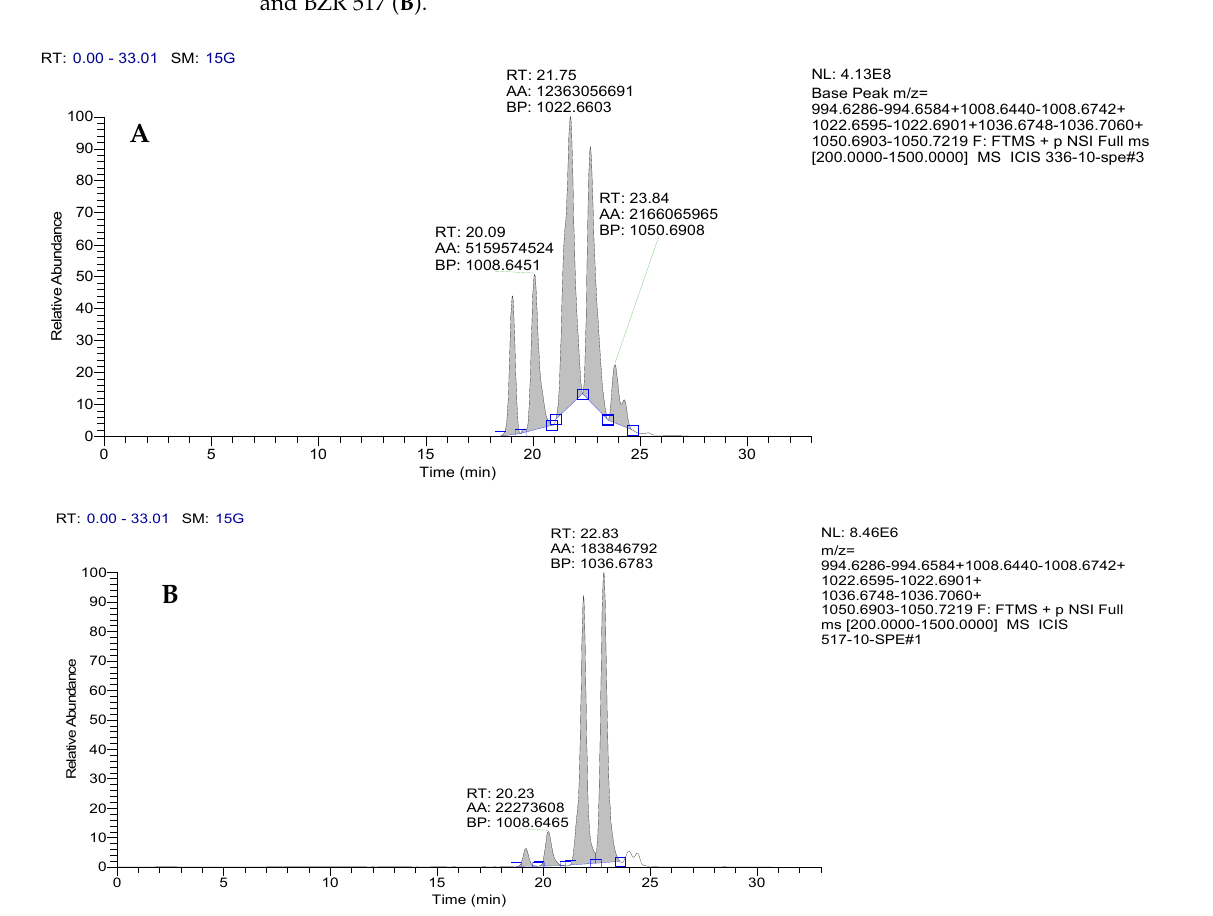
Figure 11. HPLC-ESI+-HRMS spectra of Surfactin A-CH 2 , Surfactin A, Surfactin B, Surfactin C, and Surfactin C + CH 2 for sample BZR 336 g.